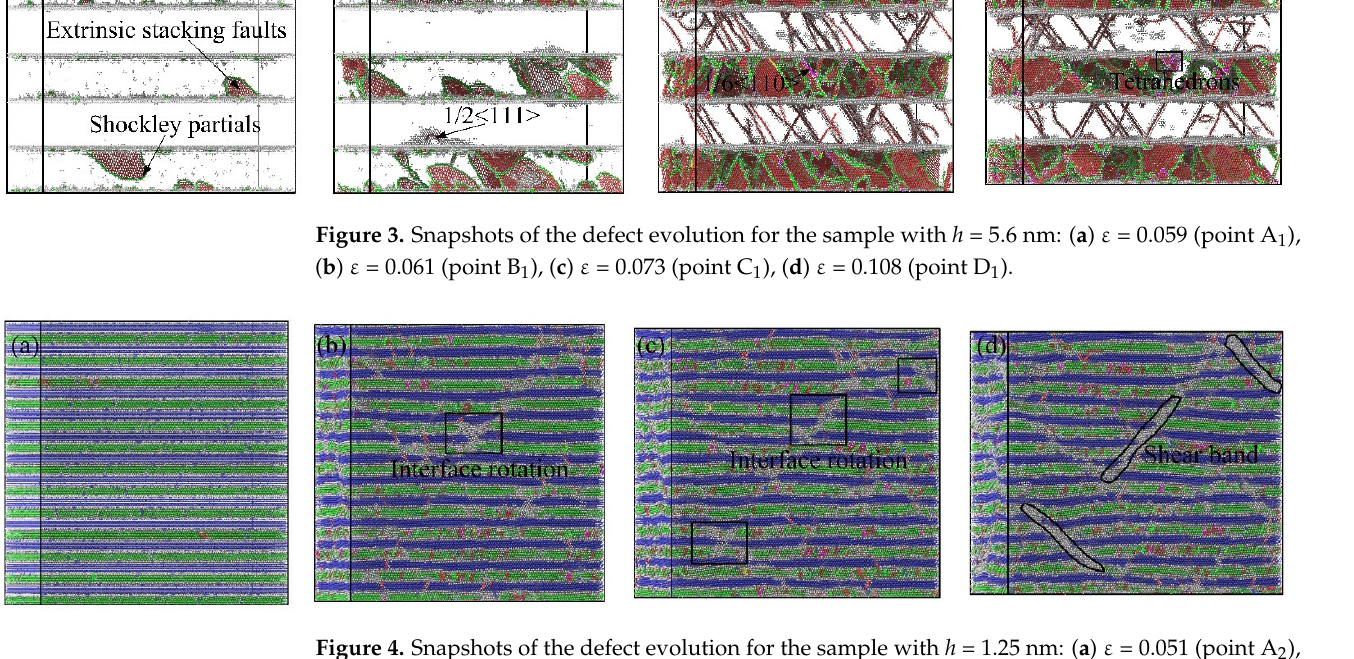
Figure 4. Snapshots of the defect evolution for the sample with h = 1.25 nm: ( a ) ε = 0.051 (point A 2 ), ( b ) ε = 0.073 (point B 2 ), ( c ) ε = 0.118 (point C 2 ), ( d ) ε = 0.14 (point D 2 ).